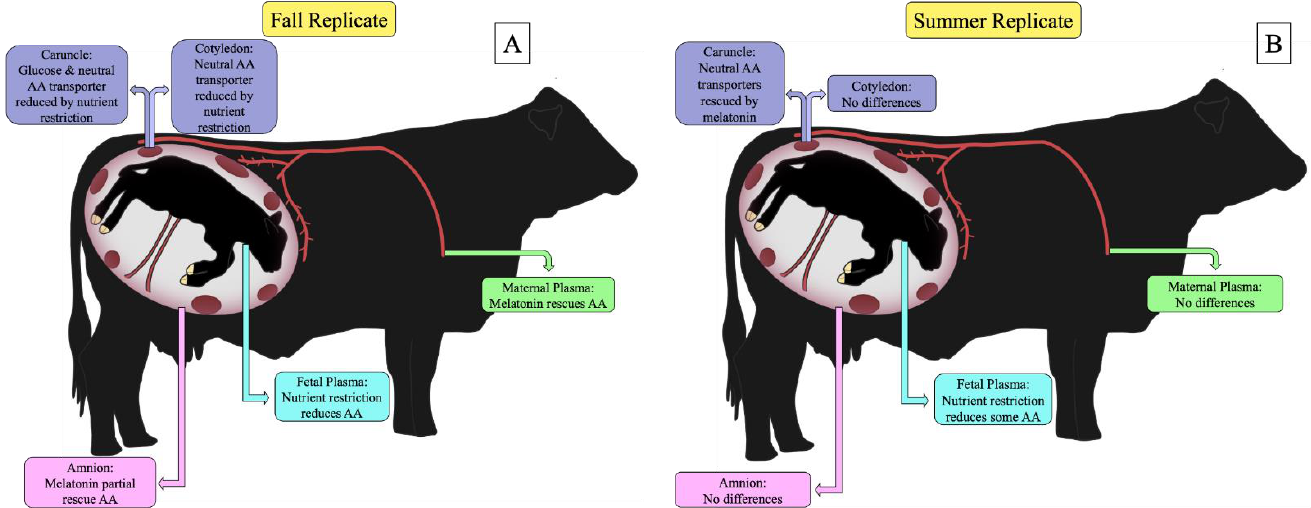
Figure 1. Summary of main findings in the fall and summer replicate of melatonin supplemented nutrient restricted cows. Including maternal, fetal, and amnion amino acid concentrations, and placental nutrient transporters in the caruncle and cotyledon. ( A ) Summary of findings in maternal and fetal blood, amnion, and placenta in the fall replicate; ( B ) Summary of findings in maternal and fetal blood, amnion, and placenta in the summary replicate.